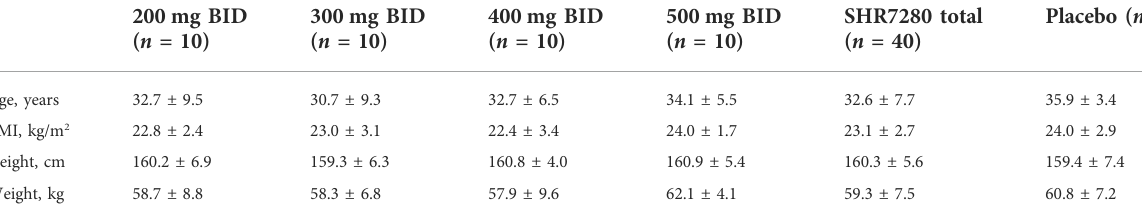
TABLE 1 Baseline